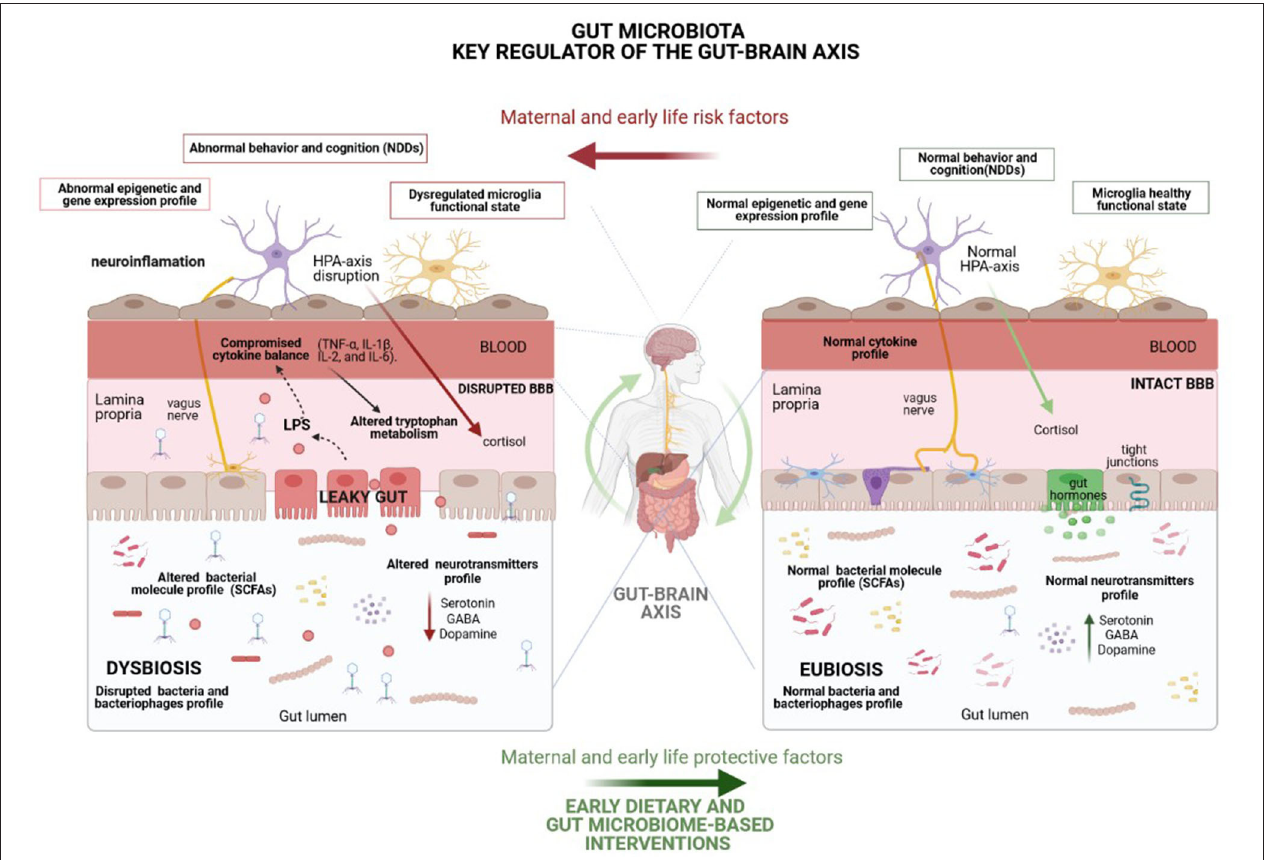
FIGURE 2 | Representation of the underlying mechanisms, including immune (cytokine balance and microglia function), metabolic (short-chain fatty acids), endocrine (cortisol) and neural (vagus and enteric nervous system-ENS) pathways, by which the gut microbiota modulates the gut–brain axis and, consequently, brain function and behavior. Many environmental factors may disturb gut microbiota homeostasis, leading to a microbial imbalance (dysbiosis) which enhances the risk of NDDs mainly through gut permeability disruption, as well as by the disturbance of the host stress hormones and cytokine profile and the alteration of neurotransmitter metabolism and levels of other crucial neuroactive molecules. Highlighted potential of healthy dietary interventions to curb the harmful effects of life stressors on gut microbiota composition and mental health. HPA, Hypothalamic-pituitary-adrenal; BBB, Blood brain